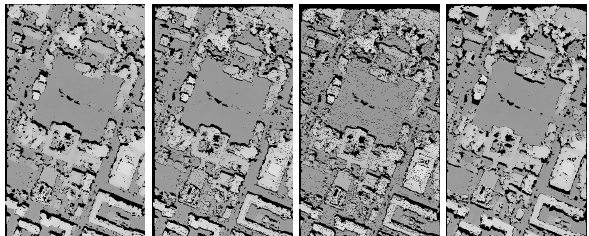
Figure 2. Height map fitting on first pan image, DSM derived from left height map, DSM derived from right height map, height map fitting on second pan image (l.t.r.), 300 m × 500 m